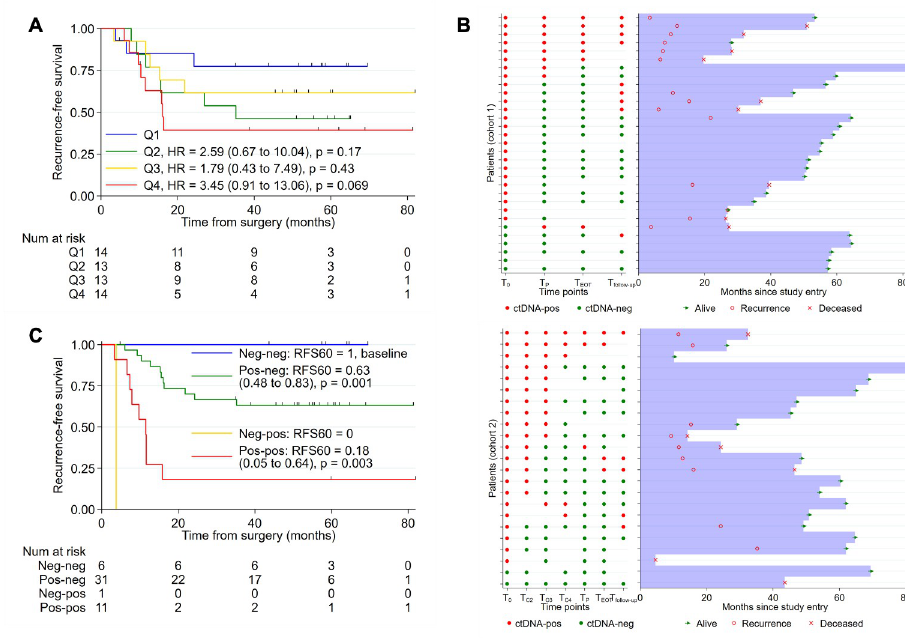
Fig 6. Baseline ctDNA MAF, pre- and postoperative ctDNA, and clinical outcome. (A) RFS stratified by baseline ctDNA MAF quartiles; MAF cut-offs: Q1 � 0.15, Q2 > 0.15 and � 1.04, Q3 > 1.04 and � 7.2, Q4 > 7.2. (B) Swimmer plot showing serial ctDNA detectability and clinical outcomes for patients in cohort 1 and 2. (C) RFS according to serial baseline and postoperative ctDNA status. ctDNA, circulating tumor DNA; MAF, mutant allele fraction; RFS, recurrence-free